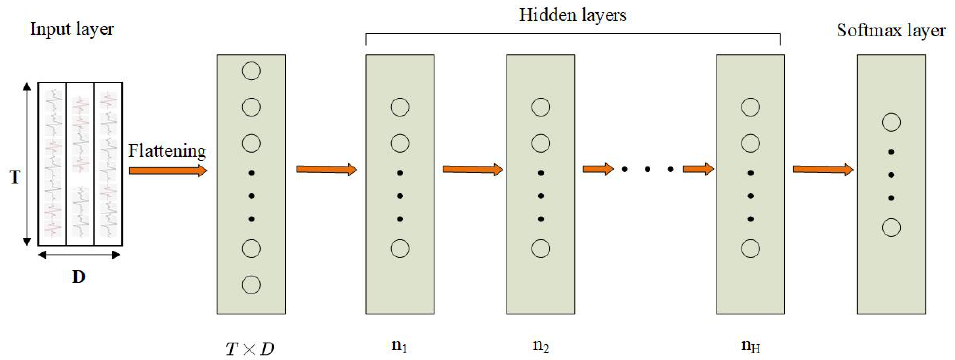
Figure 3. Architecture of a multi-layer perceptron (MLP) for HAR. T in the input layer denotes the length of the time window. D denotes the number of sensor channels. H denotes the number of hidden layers. Input data are first flattened into a ( T × D )-dimensional vector. The vector is used as data for the hidden layers. All layers are fully